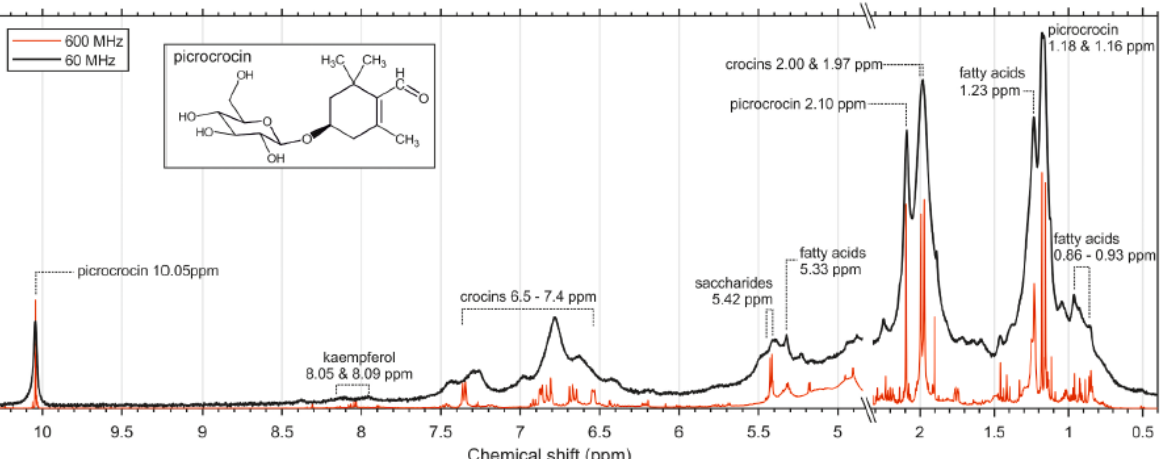
Figure 8. Comparison of 60 MHz (benchtop) and 600 MHz (high-field) 1 H NMR spectra obtained from an extract of saffron in DMSO-d6, with annotations of the main features identified in the 60 MHz spectrum. The benchtop spectral profile is dominated by resonances attributed to picrocrocin, a major saffron metabolite, the structure of which is given in the inset panel. The isolated peak at 10.05 ppm is in a generally uncrowded region of the spectrum and provides a useful indicator of the presence of saffron in a sample. Reprinted from [50], with permission from Elsevier, Copyright 2020. The analysis of pure and adulterated saffron samples at different bulking percentages (5, 10, 20, 30, 40, 50%) has allowed the detection of, through the application of DD-SIMCA, OCC-NN, and IF one-class classification approaches, statistically significant differences between analyzed samples, although the minimum detectable bulking percentage was 30%. Additionally, this approach can offer a low-cost routine method for authenticity screening. 3.5. Milk Milk is a very complex and nutritionally rich foodstuff whose study through NMR spectroscopy has allowed researchers to solve several issues related to origin, production practices, and adulteration [51 – 54]. Here, two representative examples related to milk adulteration detected by applying different NMR approaches are discussed. In the first study, high-resolution 1 H NMR spectroscopy has been applied to detect adulteration of caprine milk with cheaper bovine milk [55]. In particular, the application of PCA and OPLS-DA chemometrics approaches on 1 H binned spectra of aqueous extract of pure and adulterated (1, 5, and 10%) caprine milk has facilitated predictive models able to detect this kind of adulteration through the identification of specific markers, namely N-acetyl carbohydrates, typical of bovine milk. Interestingly, 1 H TD-NMR has also been successfully applied to detect milk adulter- ations in a study where bovine milk was spiked with known levels (from 5 to 50% v/v) of whey, urea, hydrogen peroxide, synthetic urine, and synthetic milk [56]. In particular, T 2 relaxation time was significantly affected by adulteration, showing, with respect to the T 2 value of pure milk, an increase in its value depending on the adulterant percentage. This significant difference has also been confirmed by exploratory analysis (PCA), classifica- tion (SIMCA and kNN), and proposition of regression models (PLSR), thus confirming the potential use of 1 H TD-NMR as an alternative rapid method for detecting and quanti- fying milk adulteration. 4. Third Starting Point: NMR Methodology As previously reported, each NMR methodology can be useful in investigating spe- cific aspects related to foods. In particular, high-resolution 1 H-NMR spectroscopy in